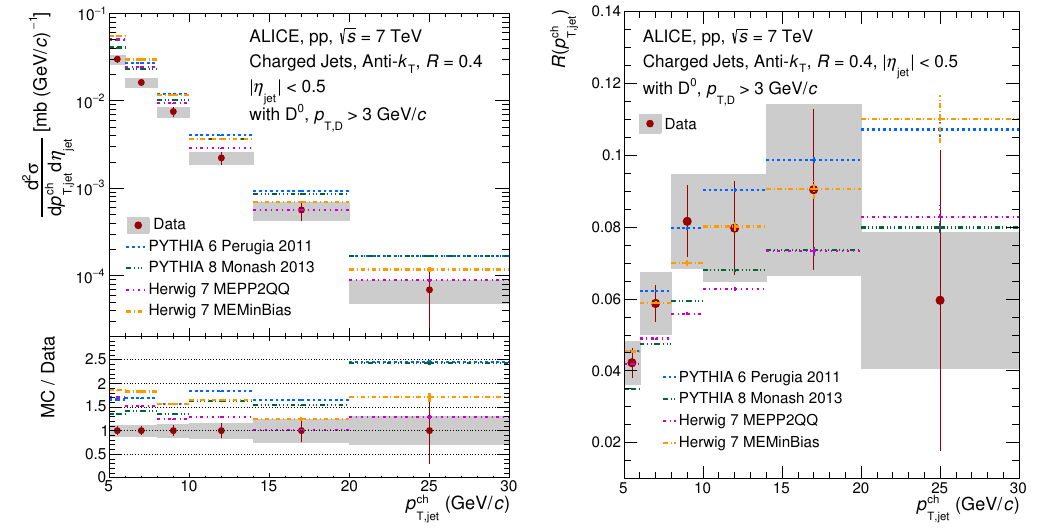
Figure 5 . p T -di(cid:11)erential cross section of charm jets tagged with D 0 mesons (left) and its ratio to p the inclusive jet cross section (right) in pp collisions at s = 7 TeV. The solid red circles show the ALICE data with their systematic uncertainties represented by the grey boxes. The measurements are compared with PYTHIA 6 Perugia 2011 (blue), PYTHIA 8 Monash 2013 (green), Herwig 7 MEPP2QQ (magenta) and MEMinBias